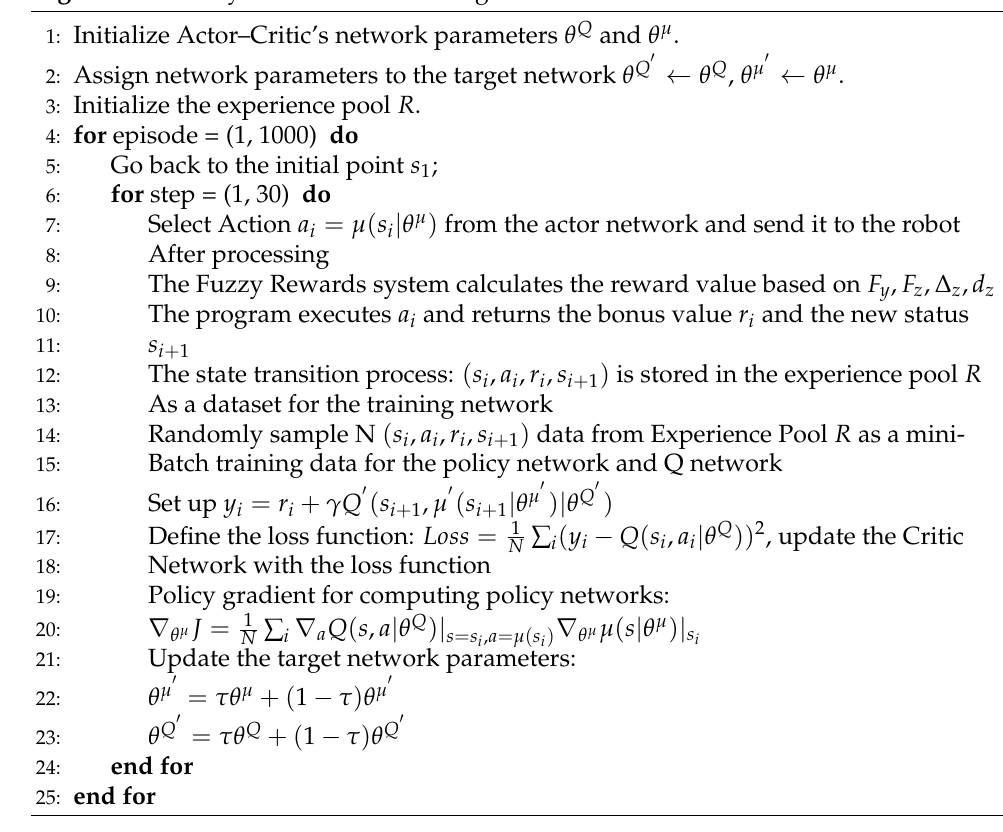
Algorithm 1 Fuzzy Rewards—DDPG